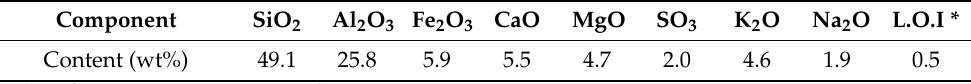
Figure 1. SEM image of the coal waste sample at ( a ) 100 × and ( b ) 1000 × magnification. Table 1. Chemical composition of the noncombustible portion of the studied coal tailings.